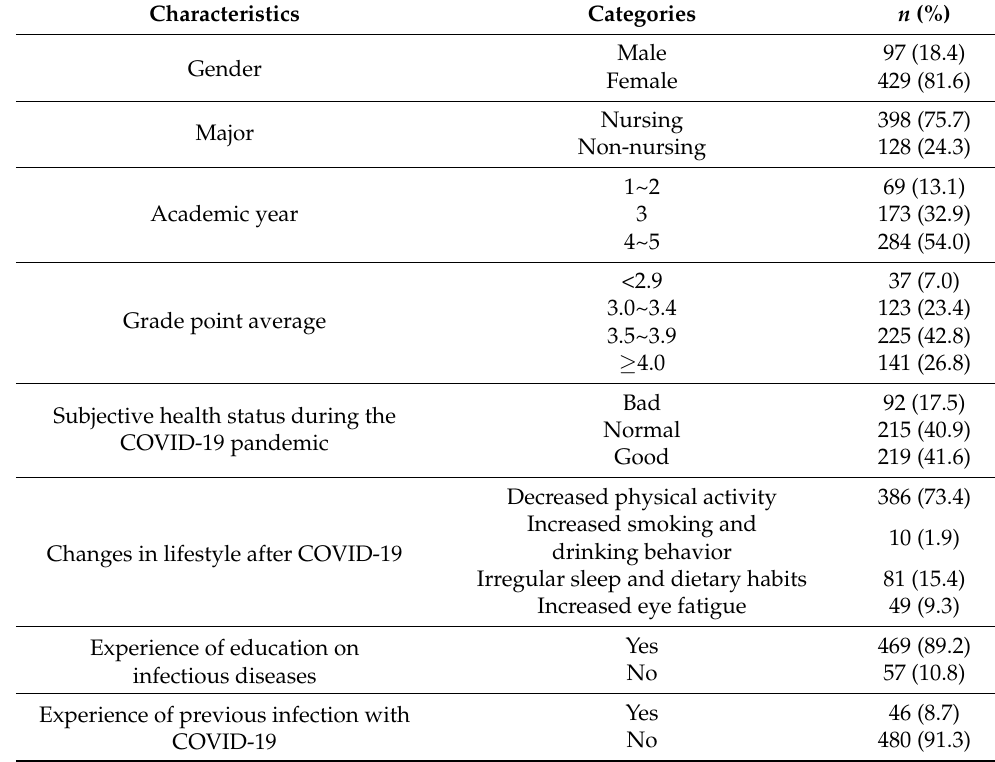
Table 1. General Characteristics of Participants ( n = 526).